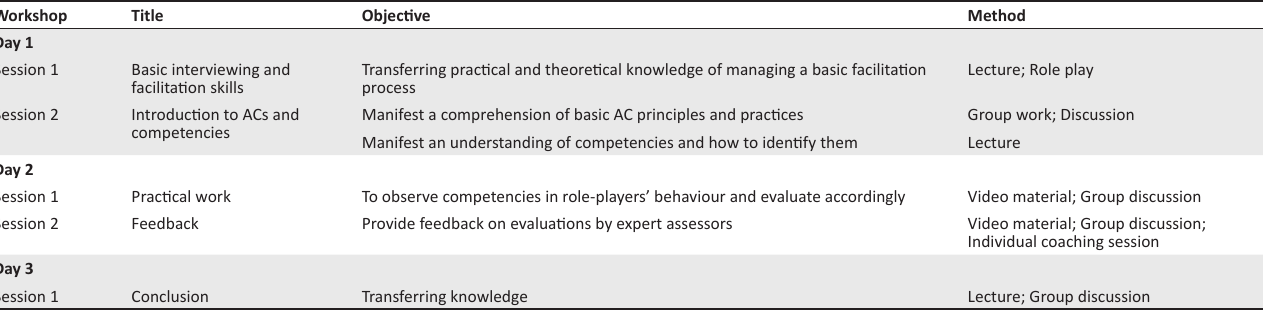
TABLE 1: The content, objectives and methodology of the FOR training programme for assessors at assessment centres. Workshop